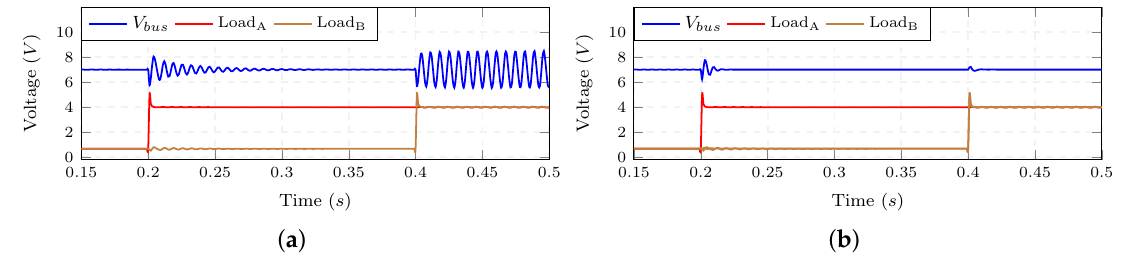
Figure 12. Simulation results for sequential switchings of Load A (at t = 0.2 s) and Load B (at t = 0.4 s): ( a ) without the proposed control; and ( b ) with the proposed control.